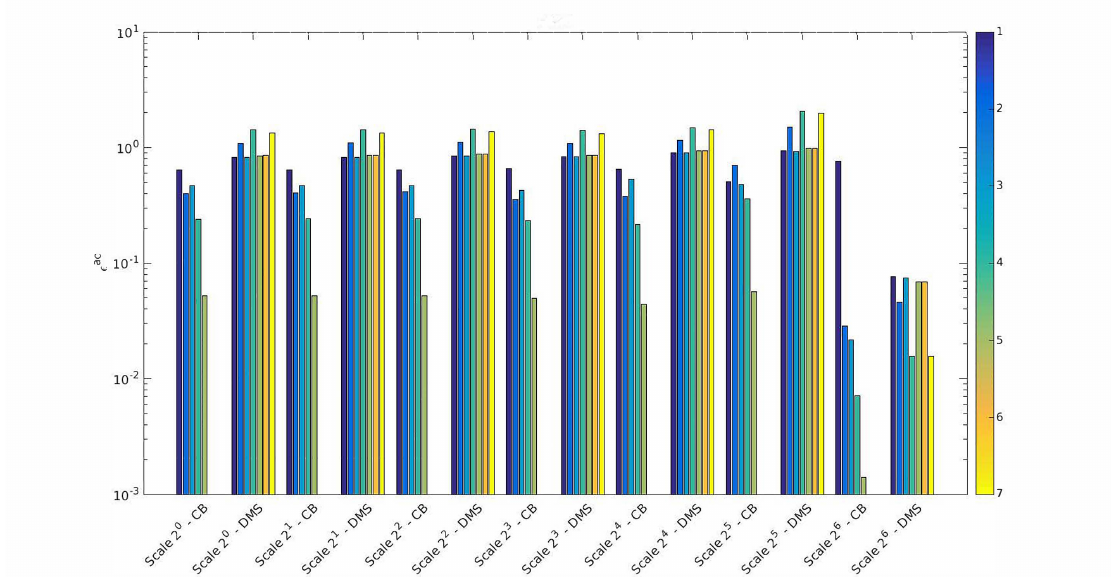
Figure 7. Values of (cid:101) ac for µ = 0.8—horizontal planes (definition of the color bar for “Scale 2 j —CB”: 1 → γ = 0.5, 2 → γ = 1, 3 → γ = 1.25, 4 → γ = 1.5, 5 → γ = 2.5; definition of the color bar for “Scale 2 j —DMS”: 1 → N DMS = 50, 2 → N DMS = 100, 3 → N DMS = 150, 4 → N DMS = 220, 5 → N DMS = 500, 6 → N DMS = 750, 7 → N DMS =